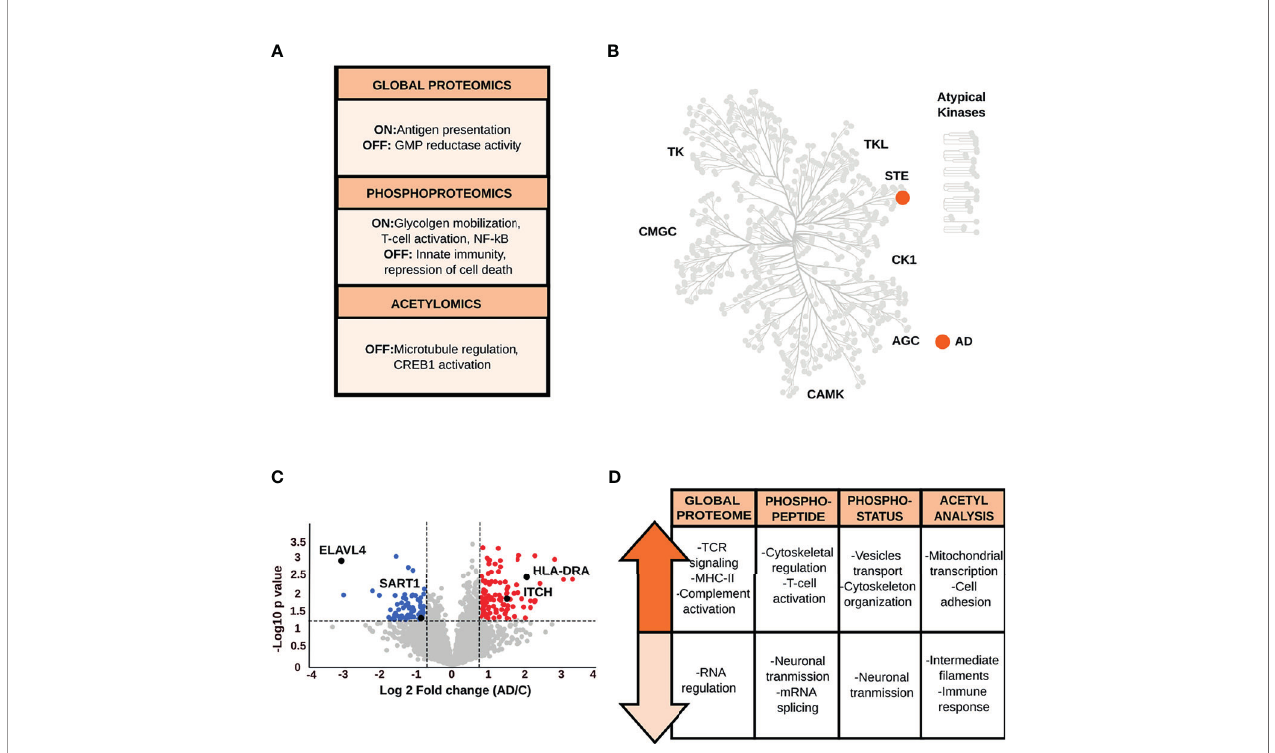
FIGURE 4 | (A) Main biological processes derived from the qualitative analysis of the EC. (B) Kinome analysis of the EC based on the qualitative comparison of AD and control data sets. (C) Volcano plot of the global proteome data representing the variation in protein abundances between AD and control samples in the EC. (D) Biological processes and pathways associated with the dysregulated proteins in the EC across all